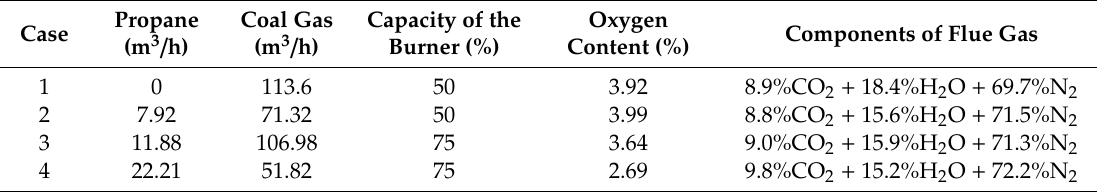
Table 2. Experimental conditions for four cases.